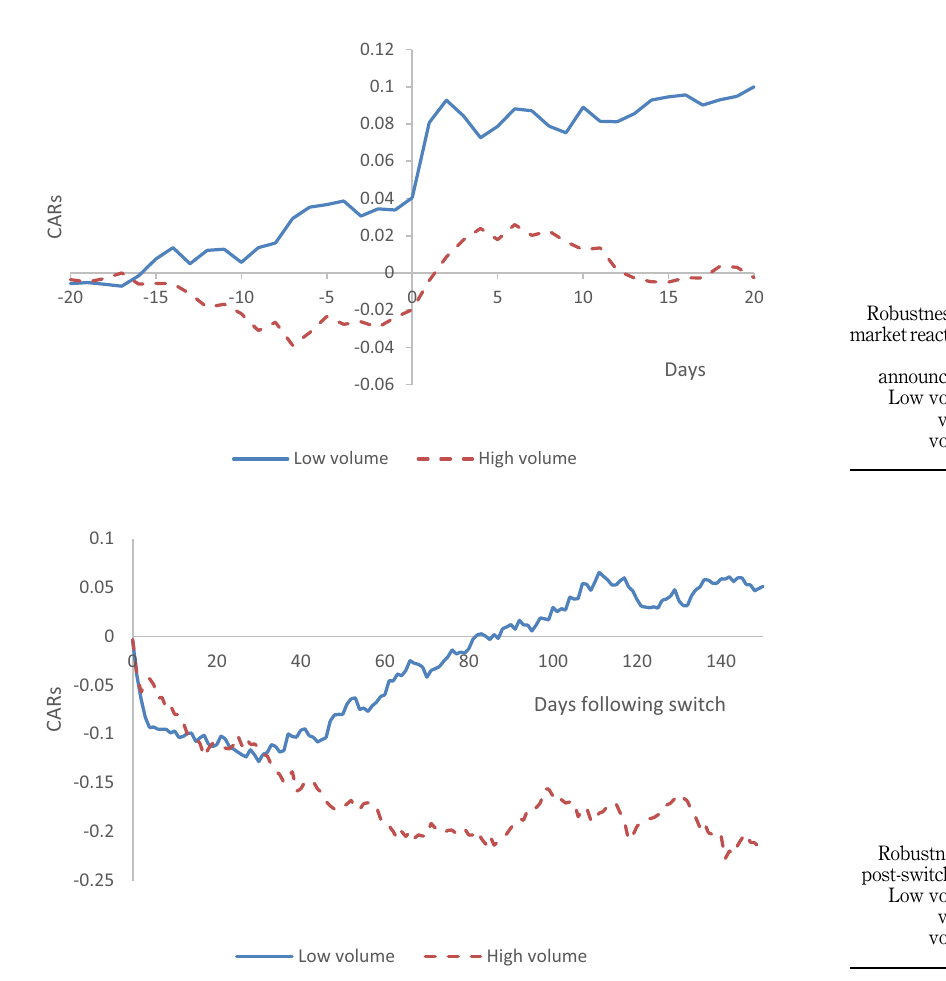
Figure 5. Robustness test